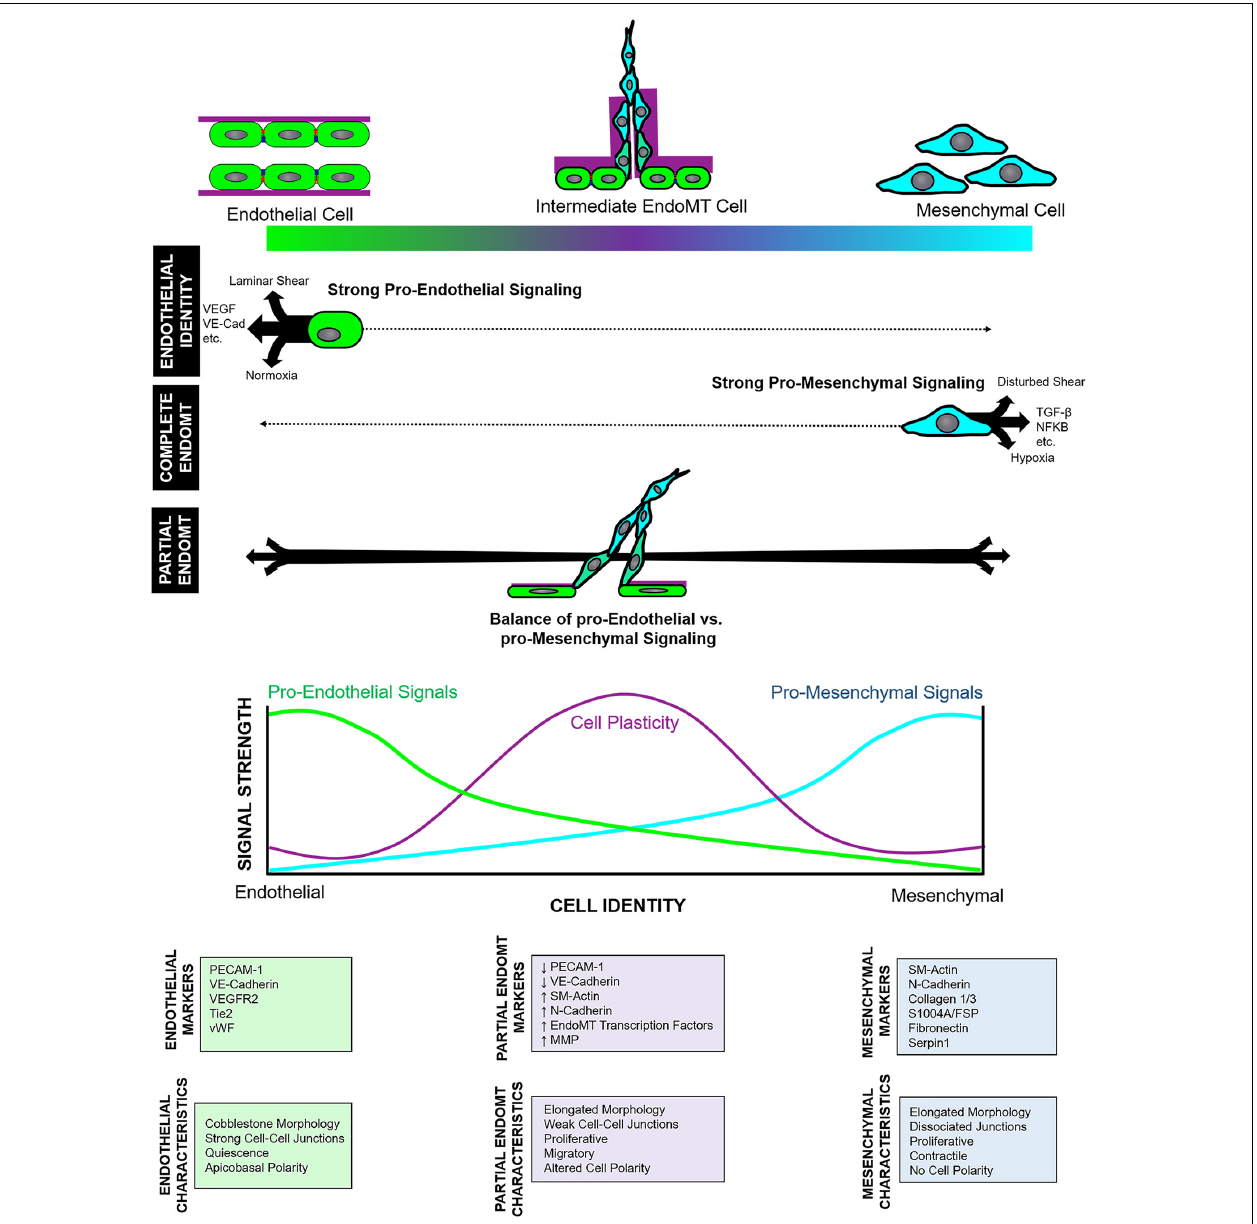
FIGURE 1 | Model of endothelial-to-mesenchymal transition (EndoMT) regulation. EndoMT describes fluid transition between endothelial and mesenchymal identities and involving a spectrum of intermediate states wherein cells acquire a mixture of endothelial and mesenchymal character and marker expression. Complete vs. partial EndoMT is established by both the relative level of pro-endothelial and pro-mesenchymal signals that “push” or “pull” cells toward either endpoint of the endothelial-mesenchymal spectrum, as well as by the extent of cell